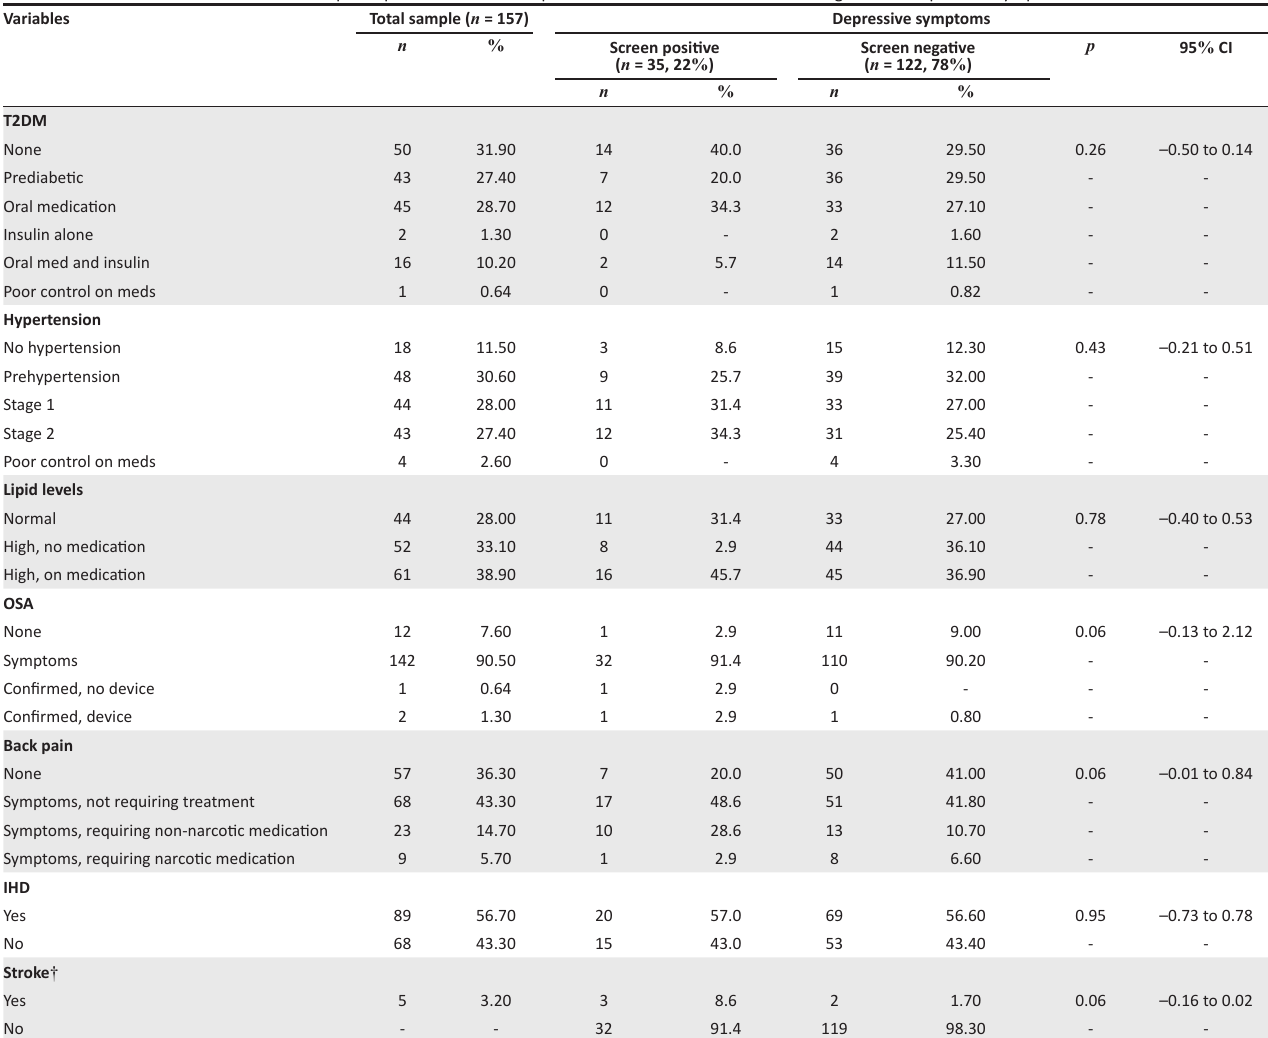
TABLE 2: Baseline clinical characteristics for participants who screened positive versus those who screened negative for depressive symptoms.